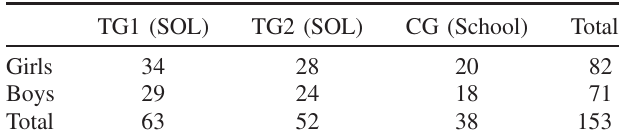
TABLE II. Sample composition (TG: Treatment group, CG: Control group).